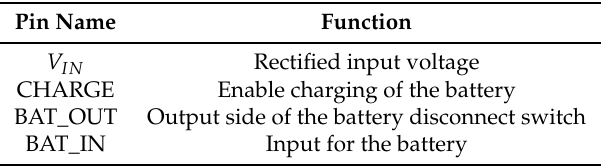
Figure 4. LTC3331 combined with LTC4071 to allow more charging current to the rechargeable batteries. Table 1. Table with the pins we used to implement the